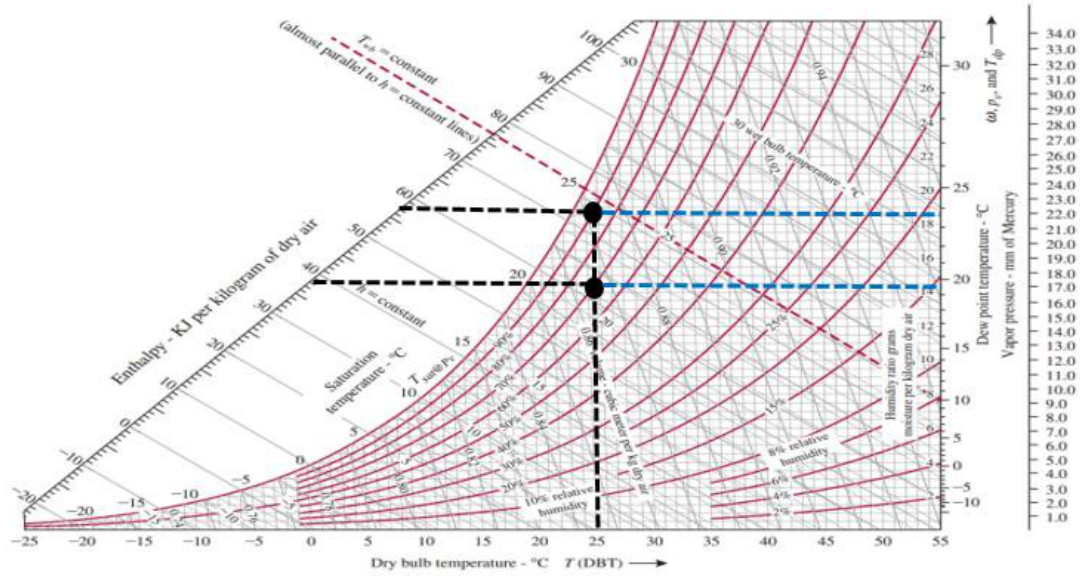
Figure 13. Effect of humidity on fan forced vaporizer performance [18].